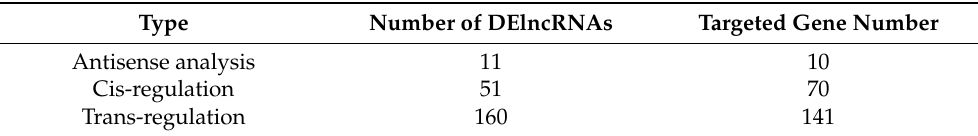
Table 4. Regulation-type statistics of DElncRNAs and